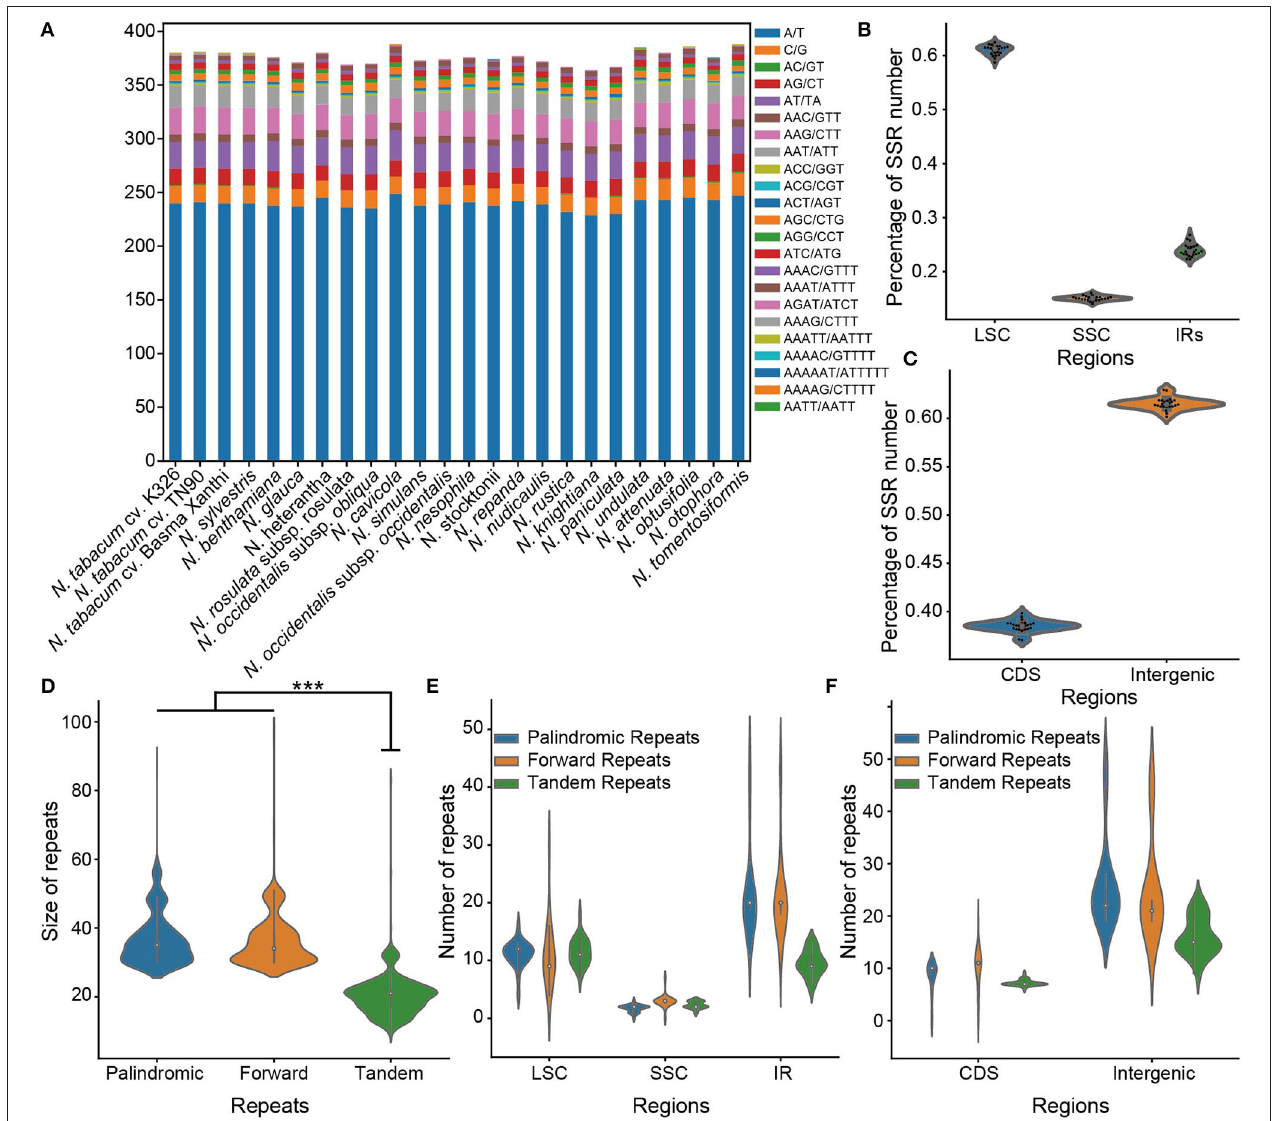
FIGURE 3 | Comparison of sample sequence repeats (SSR) and repeats among 24 chloroplast genomes of Nicotiana . (A) The number of SSRs among Nicotiana species. Each color represented the number of SSR belonging to a specific type, as provided. (B) The percentage of SSR number located in different chloroplast regions (LSC: large single-copy, SSC: Small single-copy, IR: inverted repeat region including IRa and IRb) of Nicotiana species. (C) The percentage of SSR number on CDS and intergenic regions of Nicotiana chloroplast genomes. (D) The size distribution of palindromic, forward and tandem repeats among the chloroplast genomes. (E) The number of repeats among the different regions (LSC, SSC, and IRs) of chloroplast genomes. (F) The number of repeats among the CDS and intergenic regions of chloroplast